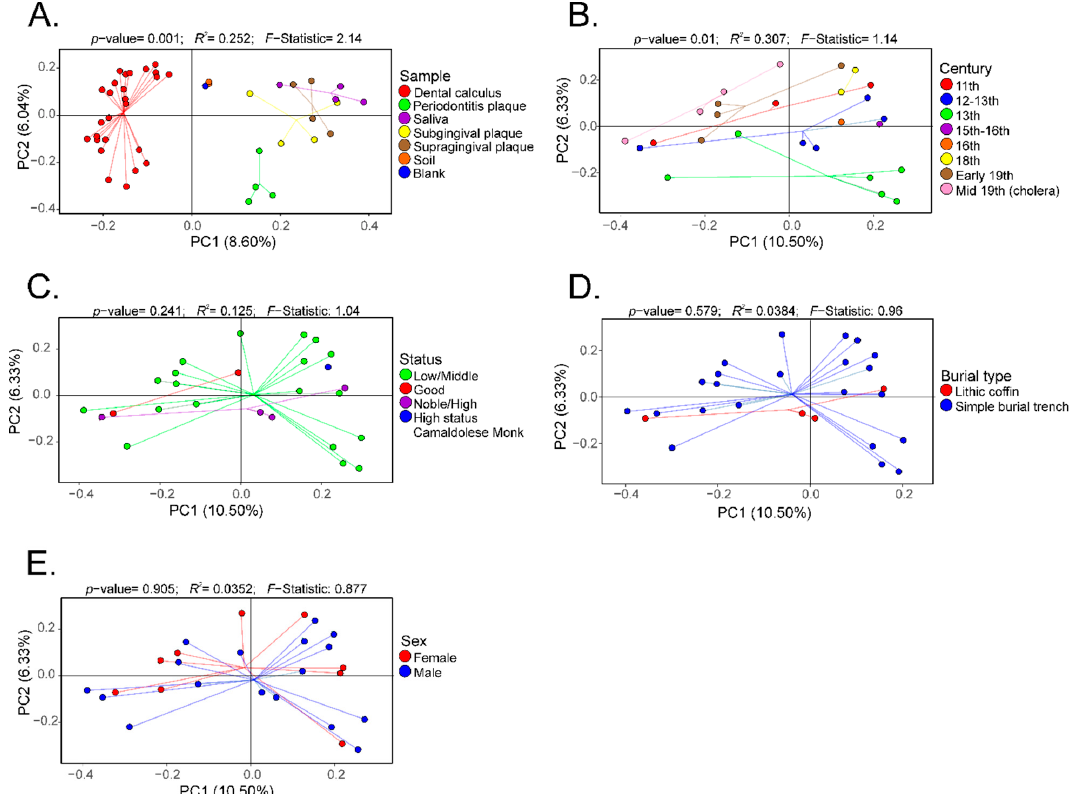
Figure 4. Principal coordinate analyses (PCoA) of the β -diversity (Bray–Curtis distances) of the dental calculus samples. The β -diversity analyses were performed based on sample type ( Panel A ), century ( Panel B ), social status ( Panel C ), burial type ( Panel D ), and gender ( Panel E ).